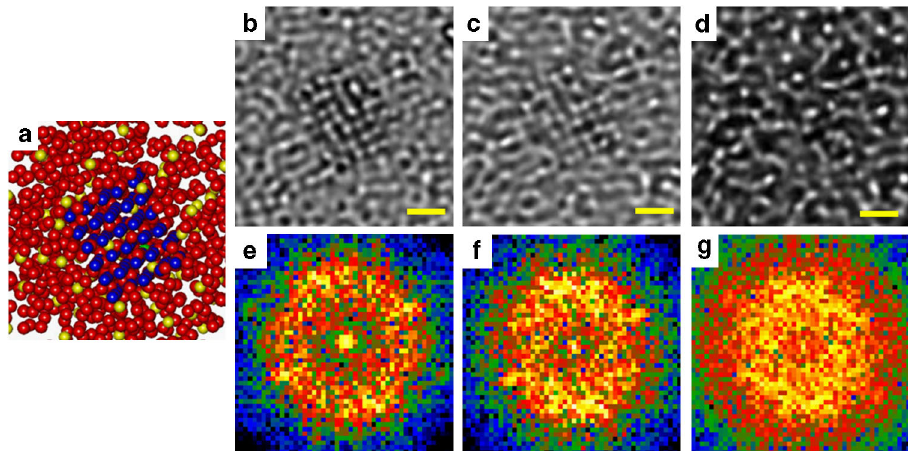
Fig. 6 HRTEM simulations of nanocrystals observed in Fe-based BMG. a Atom model and b – d corresponding HRTEM MD simulations for the 8-, 15- and 23-nm-thick samples, respectively. e – g FFTs obtained from the HRTEM simulations for the 8-, 15- and 23-nm-thick samples, respectively, which show close correlation with the FFT pattern for regions with NCs in Fig. 4 (scale bars 0.5 nm)